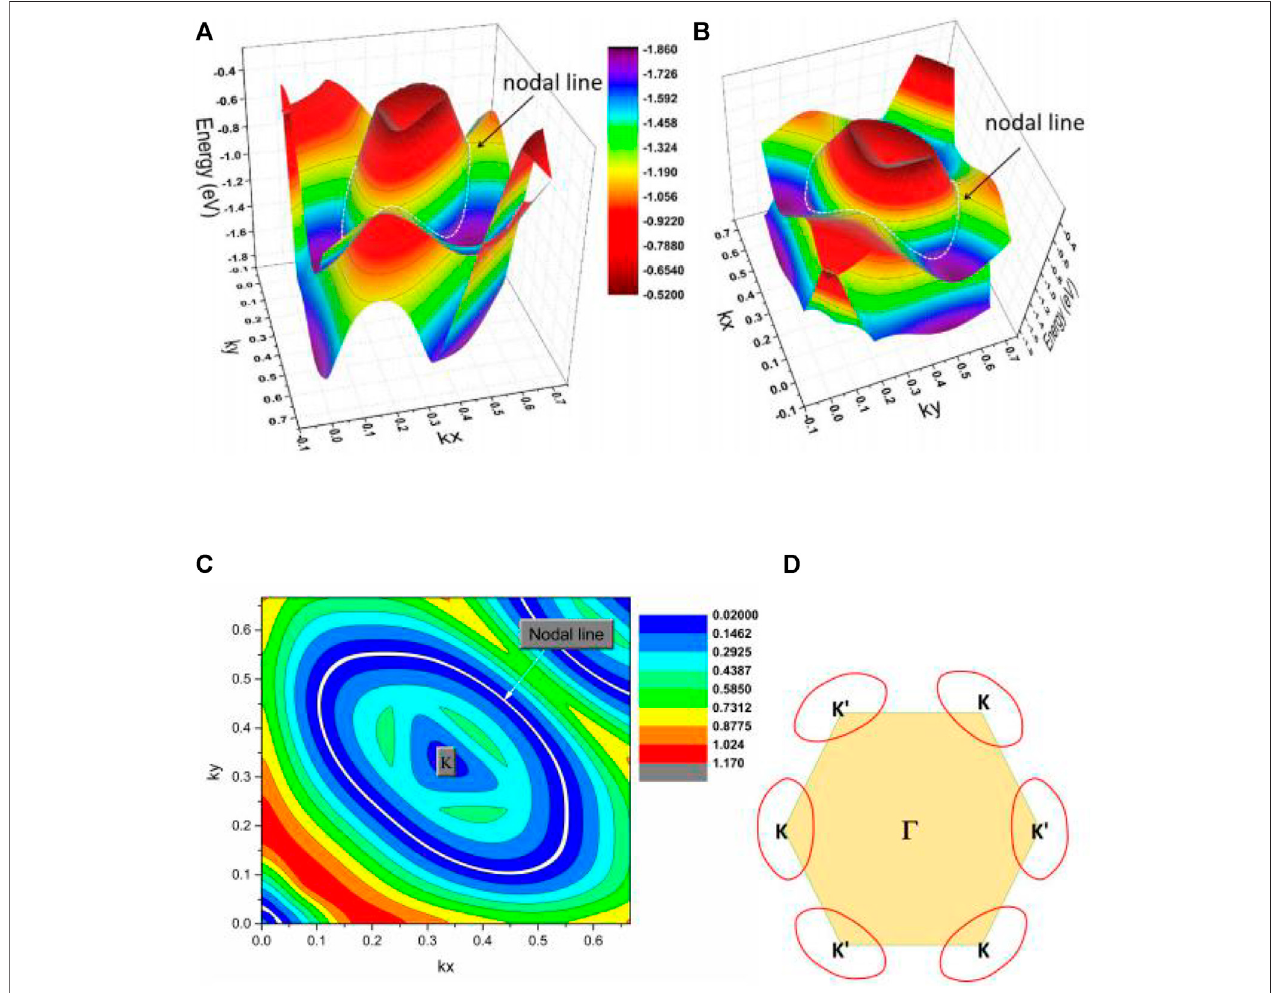
FIGURE 7 | (A,B) K-centered 3D band dispersion in region C of the kz (cid:1) 0 plane from different viewpoints. (C) The shape of the NL in region C of the kz (cid:1) 0 plane. (D) Illustration of one pair of hybrid type NLs in the kz (cid:1) 0 plane.